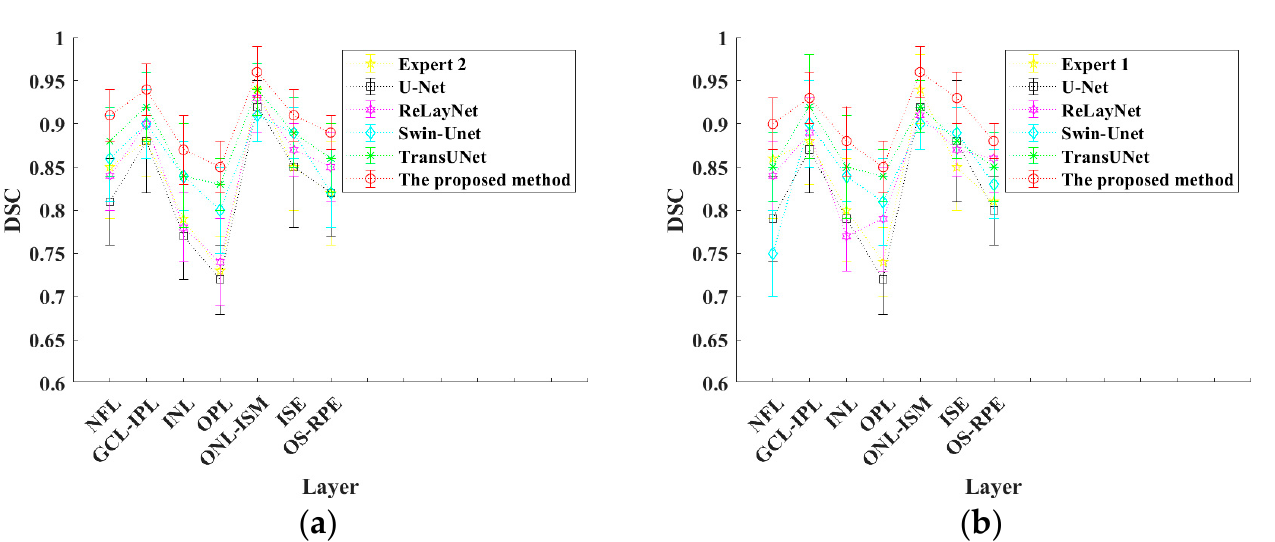
Table 2. Quantitative comparison of evaluation indicators of various methods.